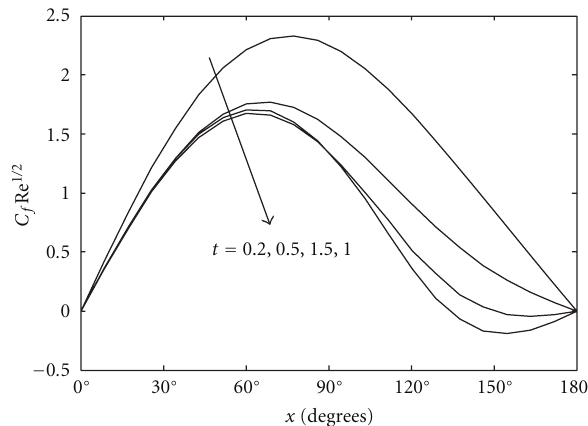
Figure 12: Variation of the skin friction coe ffi cient with x for K = 2 and for various values of t when Pr = 7, α = 1 . 25 (assisting flow) and n =